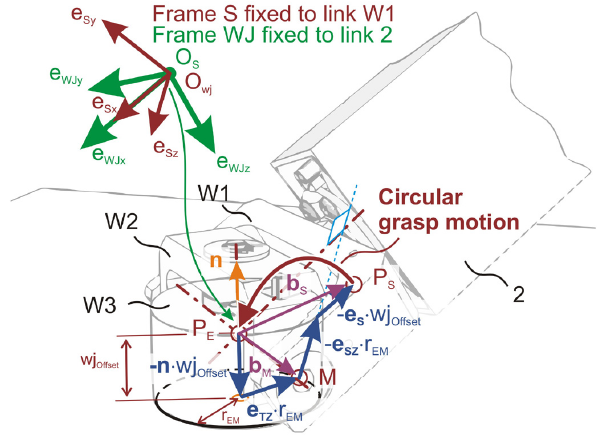
Figure 15. Enhancements for successful grasping